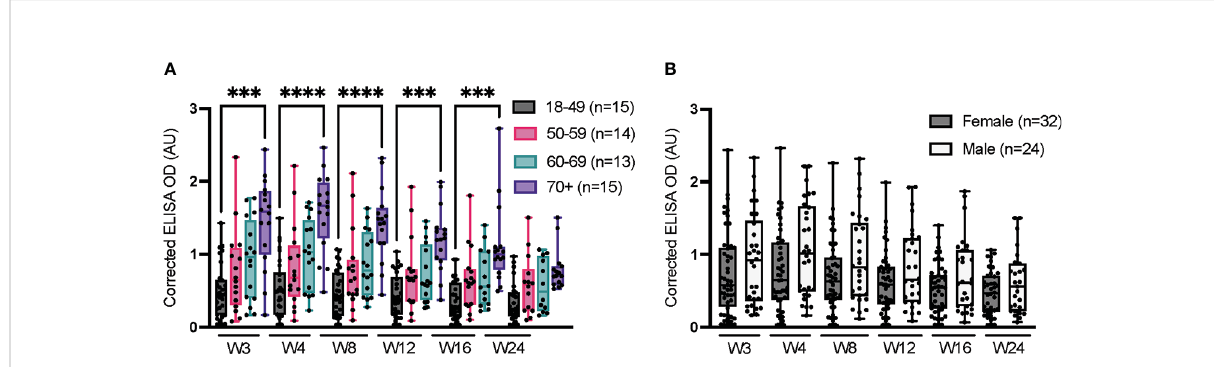
FIGURE 2 Impact of age and sex on serum anti-spike IgG over 24 weeks. ELISAs were conducted at the HQ site using serum samples from con fi rmed SARS-CoV-2-positive individuals, as in Figure 1. (A) Strati fi cation according to age. (B) Strati fi cation according to sex; the sex of one individual is unknown and was not considered in this analysis. The average of triplicate assays is given as corrected OD. The median is shown in the quartile boxplots where the whiskers include all values (no outliers excluded). ***p < 0.001; ****p <